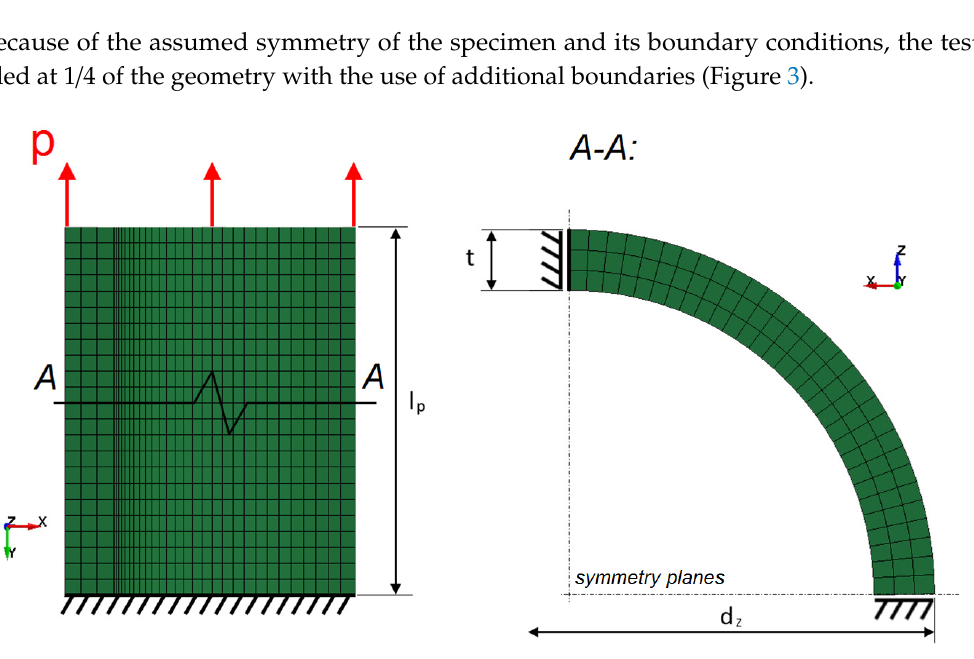
Figure 3. FEM model of a specimen tube in the longitudinal tensile test: symmetry boundary conditions are marked in black, and the displacement load is marked in red.